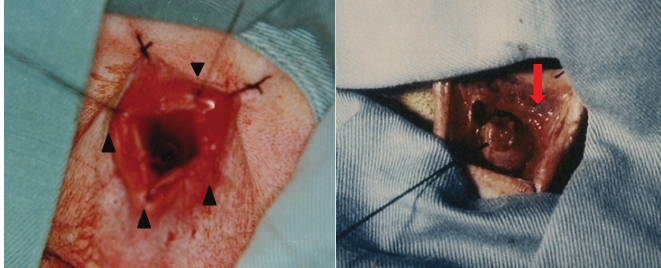
FIGuRE 3 - Telescopic ileo-anal anastomosis. A. The submucosa- mucosa graft (star) is pulled-through the muscular rectal cuff (arrow). B. 4 cardinal (arrow heads) interrupted sutures incorporating anoderm, internal sphincter, and the mucosa-submucosa of the pulled-through ileum. The animals were then divided in 3 groups of ten animals.